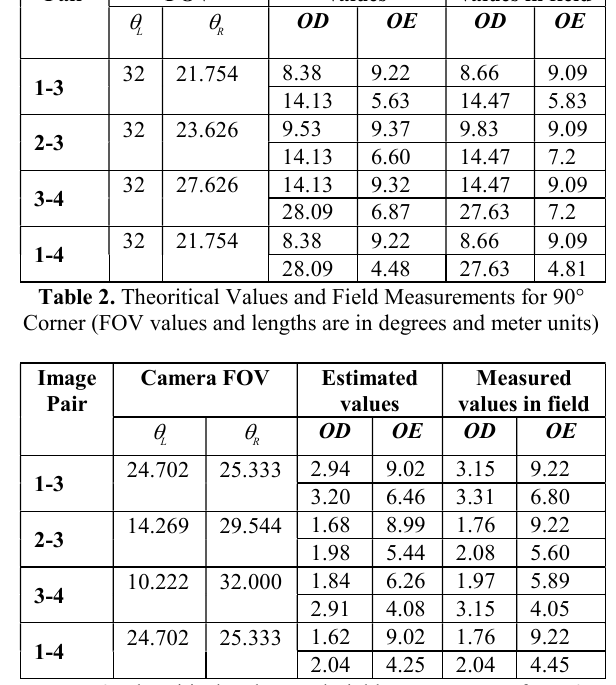
Table 3. Theoritical Values and Field measurements for 55°